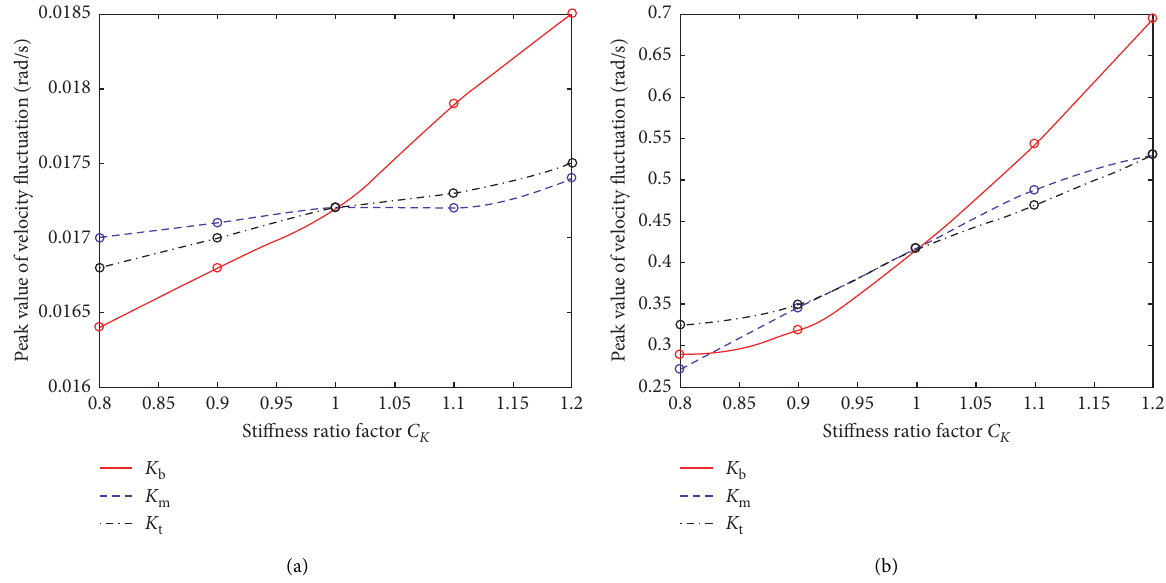
Figure 13: Peak values of velocity fluctuation with different stiffness ratio factors. (a) 60rpm. (b)